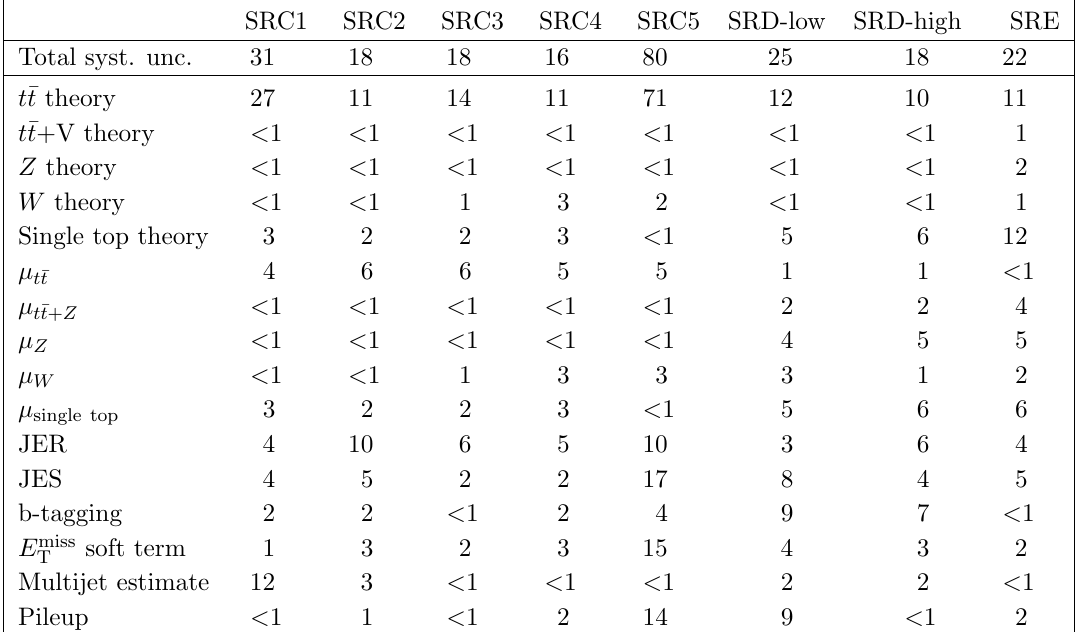
Table 10. Dominant systematic uncertainties (greater than 1% for at least one SR) for SRC, SRD, and SRE in percent relative to the total background estimates. The uncertainty due to the normalization from a control region for a given signal region and background are indicated by (cid:22) t (cid:22) t , (cid:22) t (cid:22) t , (cid:22) Z , (cid:22) W , and (cid:22) single top . The theory uncertainties are the total uncertainties for a given + Z background. Additionally, the uncertainty due to the number of MC events in the background samples is shown as \MC